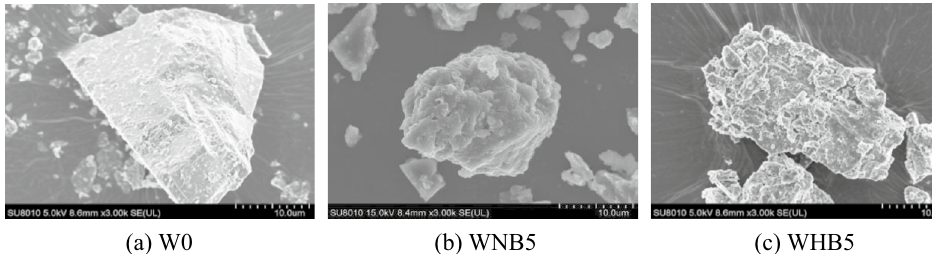
Fig. 11 Morphology and element composition of tailings